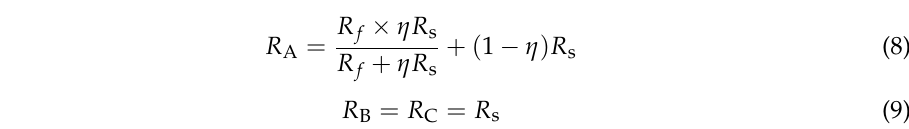
Figure 3. DC equivalent circuit when the motor has stator fault.